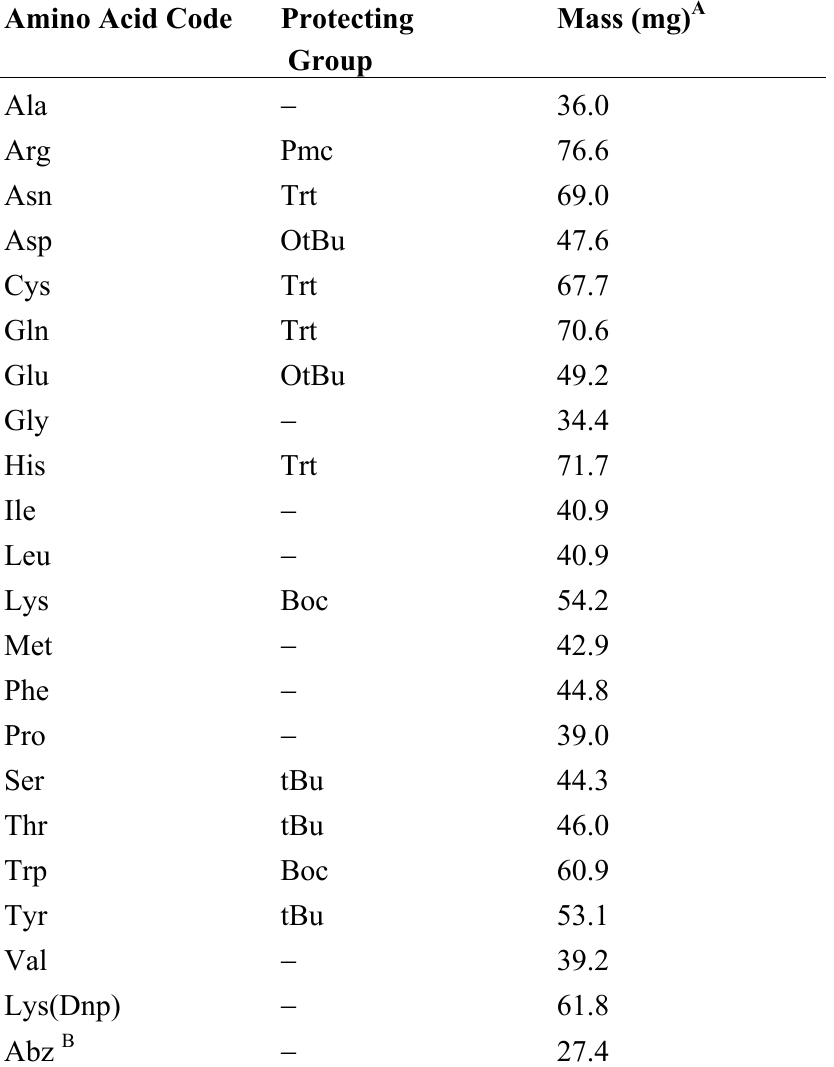
Table 1 : Mass Required of Fmoc and Side-chain Protected Amino Acids Amino Acid